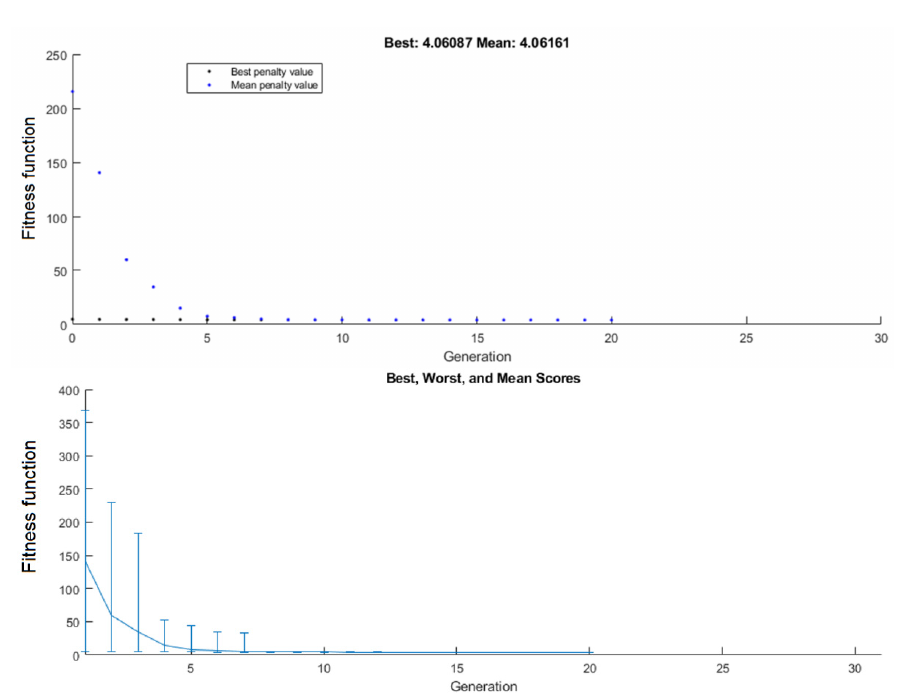
Figure 7. Best, worst, and mean genotypes during optimization process. General historical statistics of genetic algorithm.